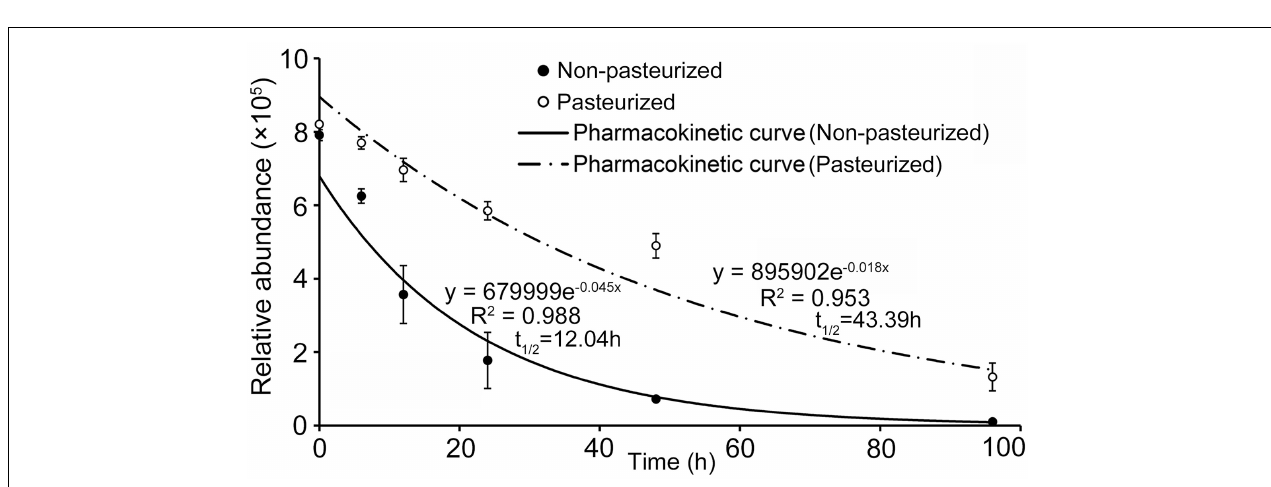
FIGURE 7 | Modified Parker phytotoxicity assay to assess the activity of catalpol and acteoside in both pasteurized and non-pasteurized soils on L. sativum (dicotyledon) and L. perenne (monocotyledon). (A) Percentage inhibition of catalpol on radicle growth of L. sativum . (B) Percentage inhibition of acteoside on radicle growth of L. sativum . (C) Percentage inhibition of catalpol on radicle growth of L. perenne . (D) Percentage inhibition of acteoside on radicle growth of L. perenne . Different letters indicate statistical difference ( p < 0.05).